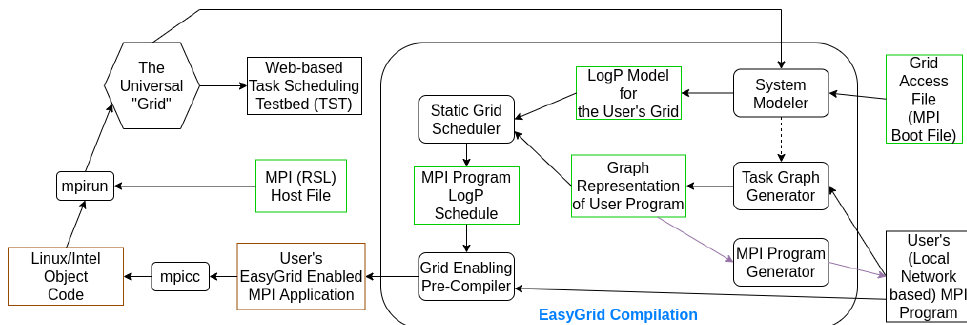
Figure 10. EasyGrid AMS—framework [64]. Based on: https://citeseerx.ist.psu.edu/viewdoc/ download?doi=10.1.1.536.1496&rep=rep1&type=pdf (accessed on 13 April 2022). Adapted